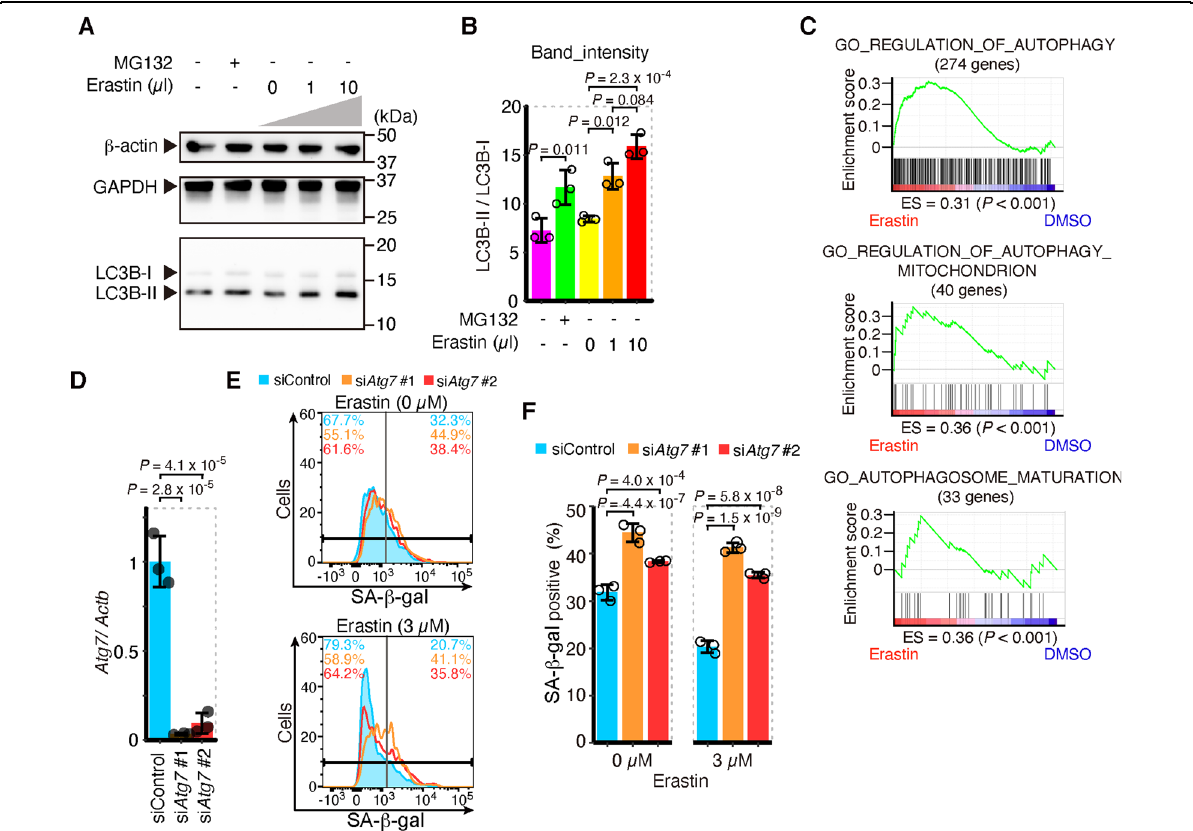
Fig. 2 Activation of autophagosome formation in ferroptotic cells leads to a decrease of SA- β -gal staining. A , B Western blotting for LC3B, β -actin, and GAPDH of MEFs exposed to erastin or 25 µM MG132 for 12 or 6 h, respectively. A Representative image and ( B ) the intensity of bands of LC3B. C Gene set enrichment analysis (GSEA) of genes related to autophagy regulation and autophagosome maturation in erastin or DMSO-treated MEF (left and right at the bottom); below plots, enrichment score (ES) and nominal P value, as implemented in GSEA. D – F siRNA was introduced to MEFs with lipofection. After 24 h, erastin was administered to MEFs. After 24 h of administration of erastin, SA- β -gal was assessed. D qPCR analysis for Atg7 mRNA relative to Actb mRNA. E Representative data of the histogram of SA- β -gal fl uorescence by fl ow cytometer. Values on the upper left and upper right represent, respectively, the percentage of negative and positive cells. The colors correspond to histogram traces. F Quanti fi cation of SA- β -gal-positive cells by fl ow cytometer. D – F are representative of two independent experiments carried out in triplicate. Error bars of B , D , and F represent SD. P value of B and F by Tukey ’ s test after two-way ANOVA. P value of D by Tukey ’ s test after one-way